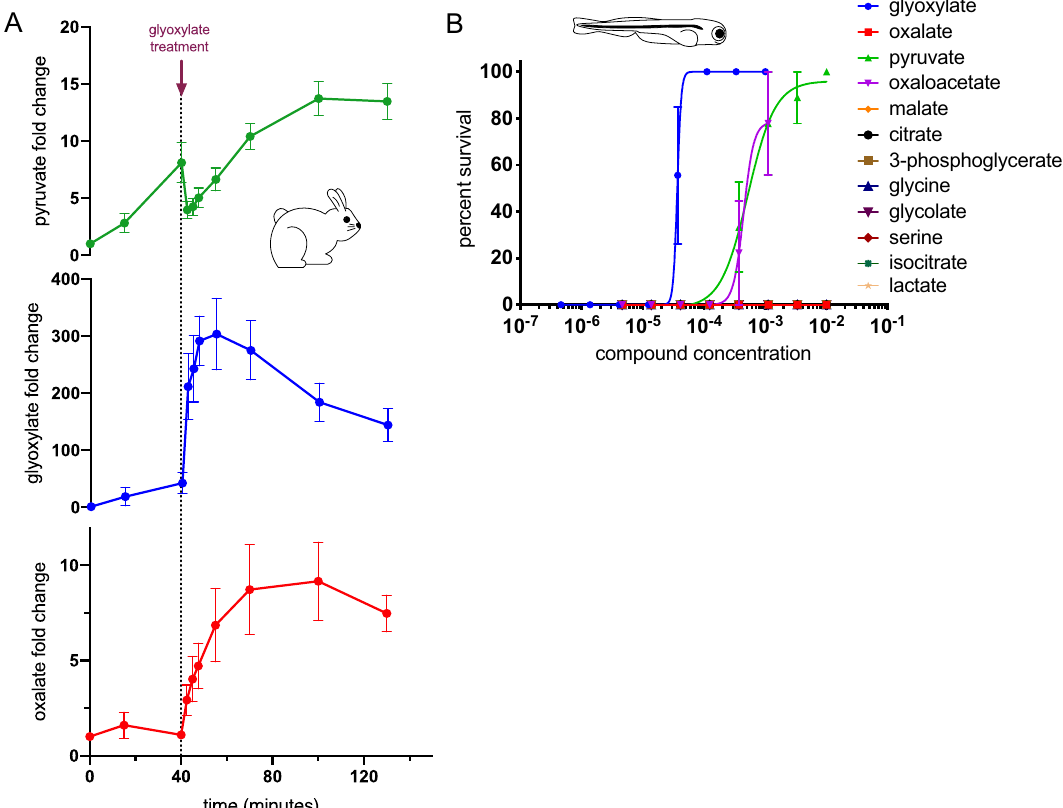
Figure 5. Direct metabolites of glyoxylate do not rescue with comparable efficacy. ( A ) Metabolite profiling was performed on serial plasma samples collected from rabbits at baseline, during cyanide exposure, and subsequent to i.m. administration of glyoxylate. The pharmacokinetic profile of exogenous glyoxylate is depicted in blue. Data are represented as mean fold change from baseline ± SEM, N = 9. ( B ) Dose-dependent survival of 5 dpf zebrafish embryos treated with metabolites closely related to glyoxylate through multiple metabolic pathways. Oxaloacetate was 100% lethal at the two highest doses. These data points were removed to preserve an accurate dose–response curve. 3 fish per well, N = 3 wells. Data presented as mean ±